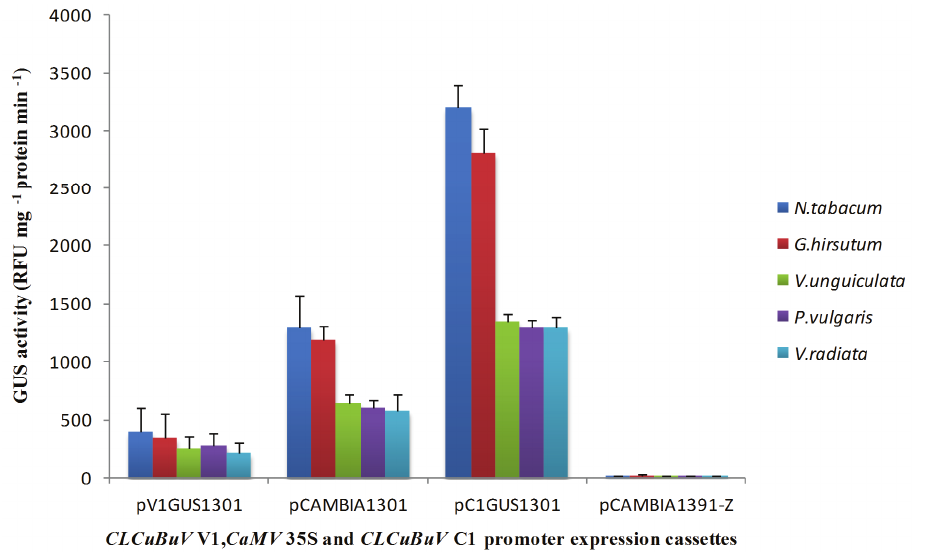
Figure 3. Transient GUS expression in plant leaves and roots agro-inoculated with the AC1 and AV1 promoter constructs from CLCuBuV (pV1GUS1301, pC1GUS1301) in comparison with positive control CaM 35S promoter (pCAMBIA1301) and a negative promoterless control (pCAMBIA1391-Z). Error bars represent standard deviation.GUS activity measured in RFU mg − 1 protein min − 1 . Each treatment was carried out in three